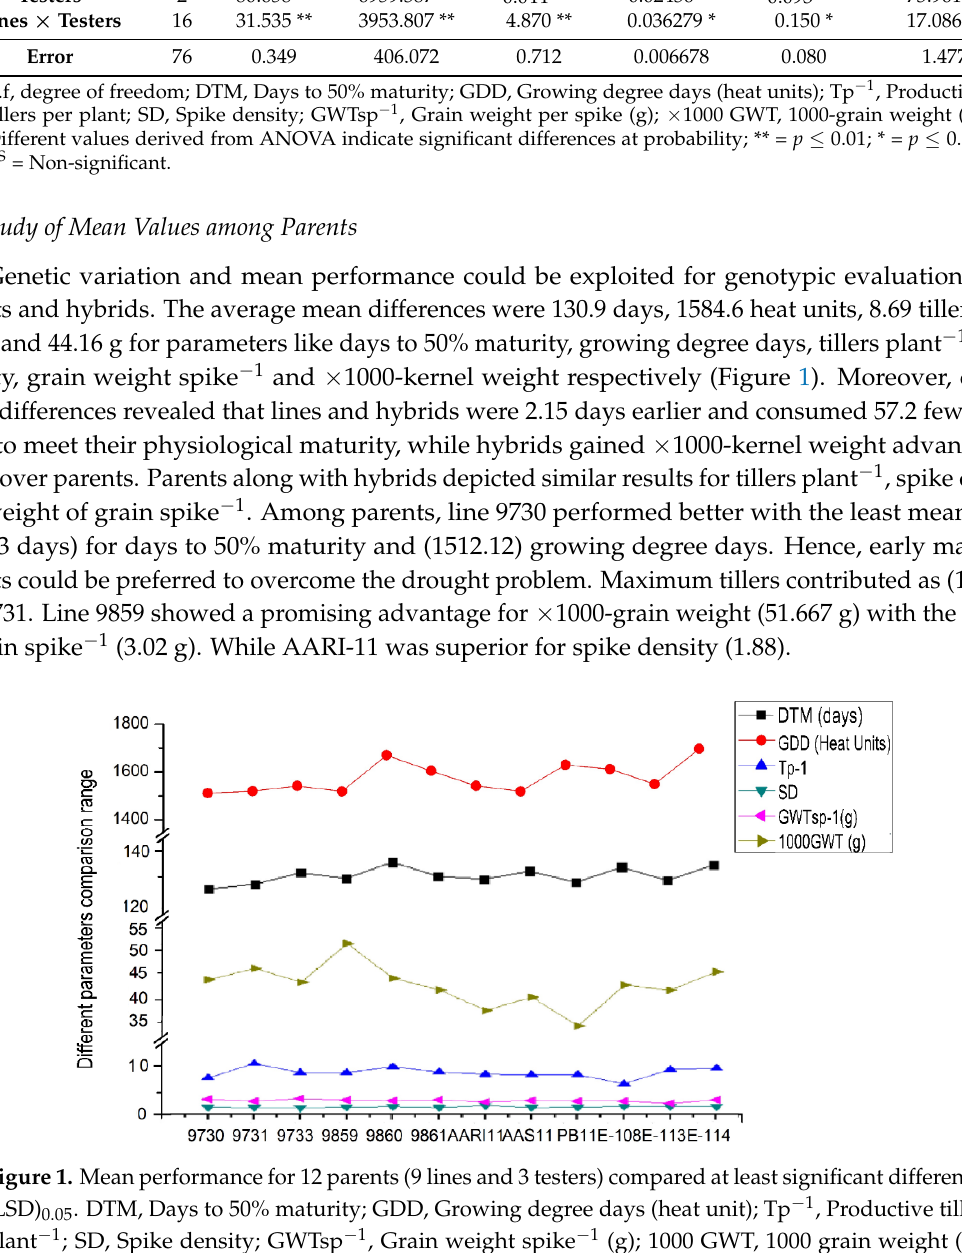
the traits: 13.66 days, 189.25 heat units, 5.44 tillers, grain weight spike − 1 (0.913 g) and × 1000-grain weight (11.93 g) (Figure 2). The minimum mean values were observed in crosses PB-11 × E-113 and 9731 × E-114 for days to 50% maturity and growing degree days respectively. However, mean